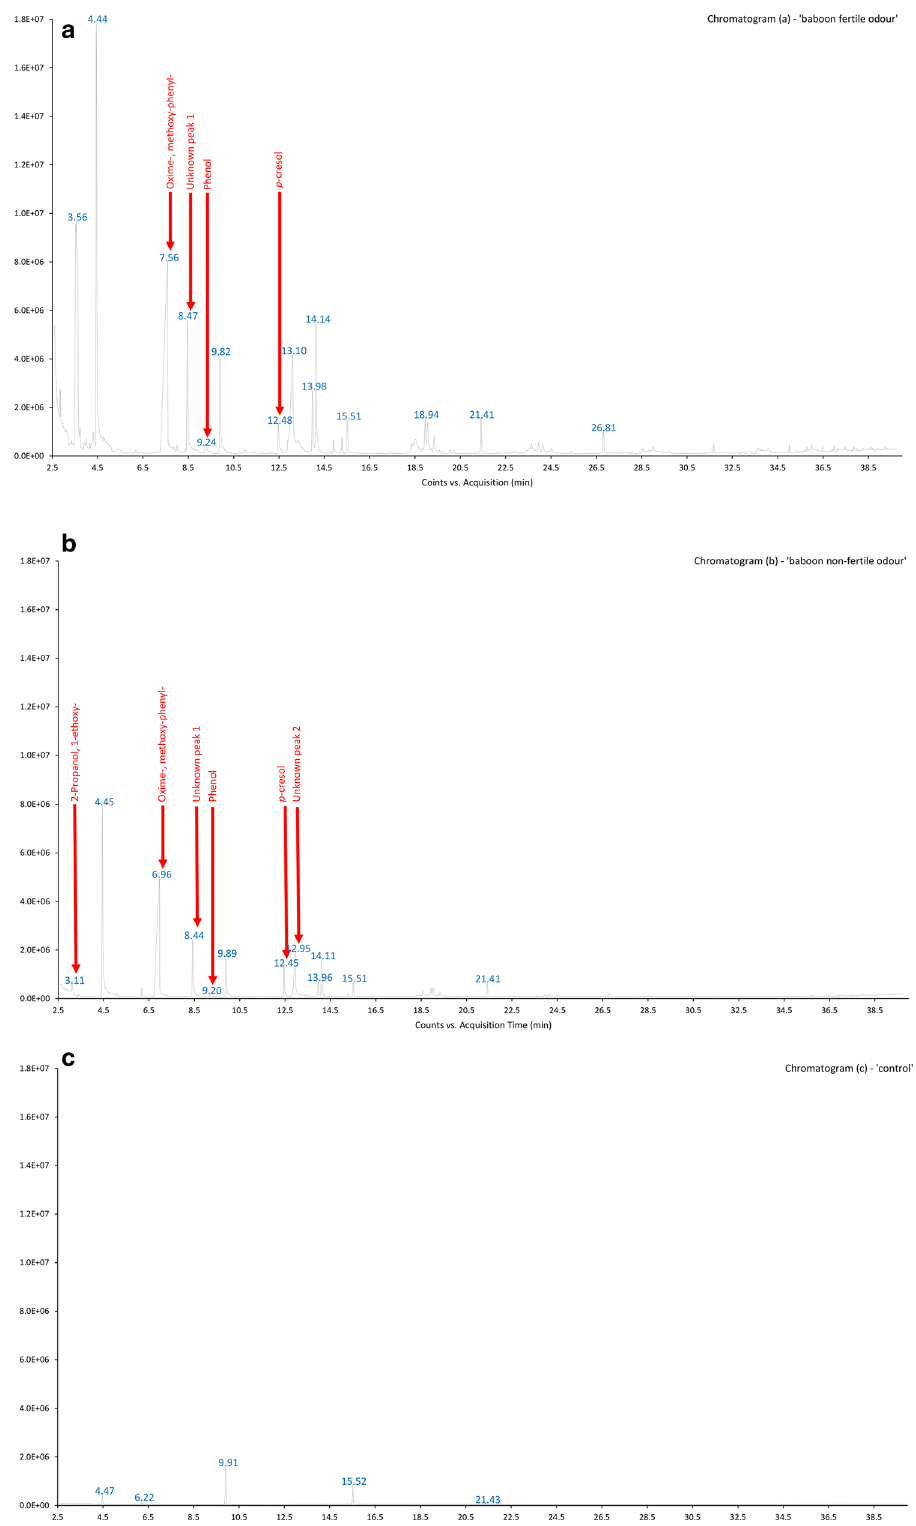
Figure 3. Example chromatograms from female olive baboon, vaginal odour sample from fertile period (chromatogram ( a )—‘baboon fertile odour’); female olive baboon, vaginal odour sample from non-fertile period (chromatogram ( b )—‘baboon non-fertile odour’); and control sample, showing contaminants (chromatogram ( c